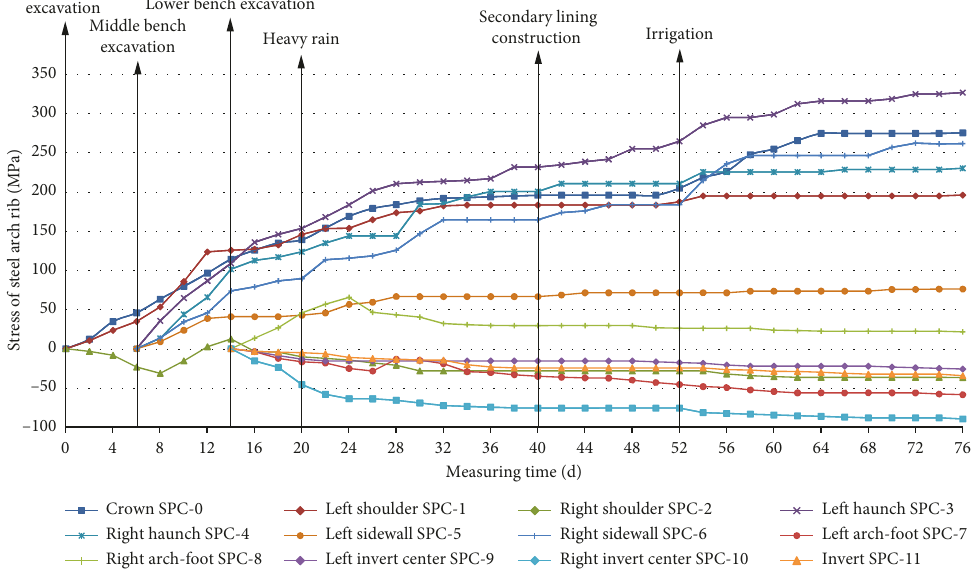
Figure 15: Monitoring results of the stress of steel arch rib.